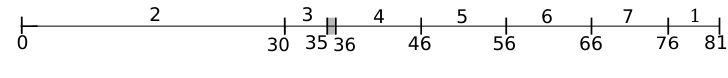
Figure 3. A complementary ED-schedule ( S 1 ) 1